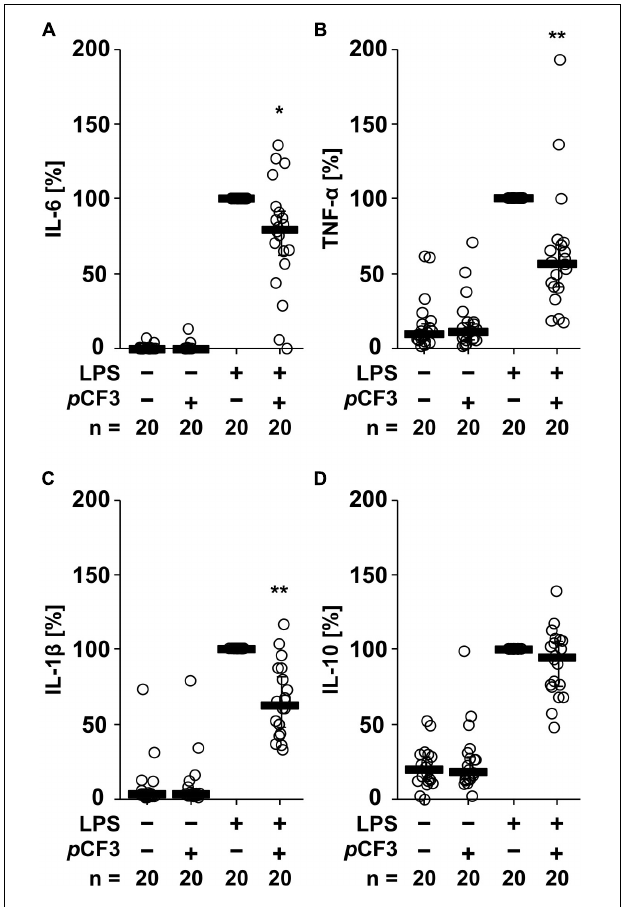
FIGURE 2 | p CF3-diEPP ( p CF3) inhibits the lipopolysaccharide (LPS)-induced release of interleukin-6 (IL-6), tumor necrosis factor- α (TNF- α ) and IL-1 β by human whole blood cells. Human whole blood was left untreated or pre-treated with 100 µ M p CF3 for 1 h, followed by a 24 h stimulation with 100 ng/ml LPS. Thereafter, LPS-induced cytokine release was measured in cell-free cell culture supernatants by BD Cytometric Bead Arrays. In the presence of p CF3 the LPS-induced release of (A) IL-6, (B) TNF- α and (C) IL-1 β was blunted, whereas no effect was seen on (D) IL-10. Cytokine levels obtained after stimulation with LPS alone were set to 100%, and all other values were calculated accordingly. Data are presented as individual data points, bars represent median, whiskers encompass the 25 th to 75 th percentile. * p ≤ 0.05 and ** p ≤ 0.01 different from cells stimulated with LPS alone. Friedman-test followed by the Wilcoxon signed-rank